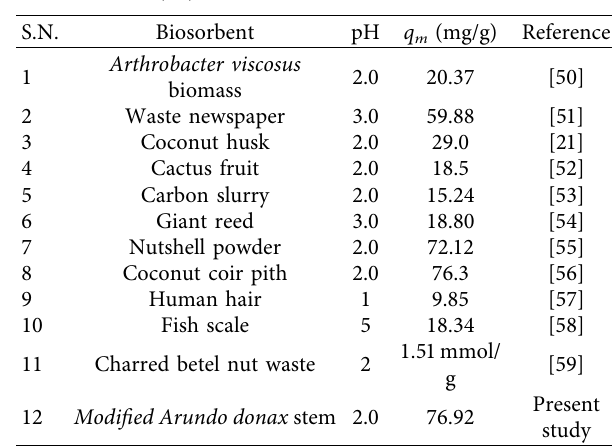
Table 3: Comparing the biosorption capacities of several bio- sorbents for Cr(VI) with CADSP.